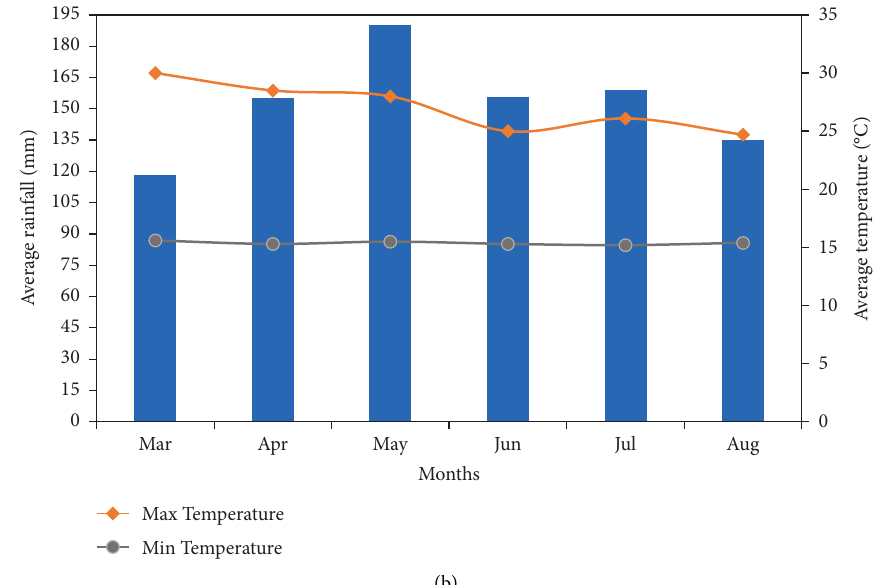
Figure 2: Monthly average rainfall and maximum and minimum temperature of Hawassa recorded during 1990–2019 (a) and during the experimental season (b) (data source: National Metrology Service Agency [32], Hawassa Branch,